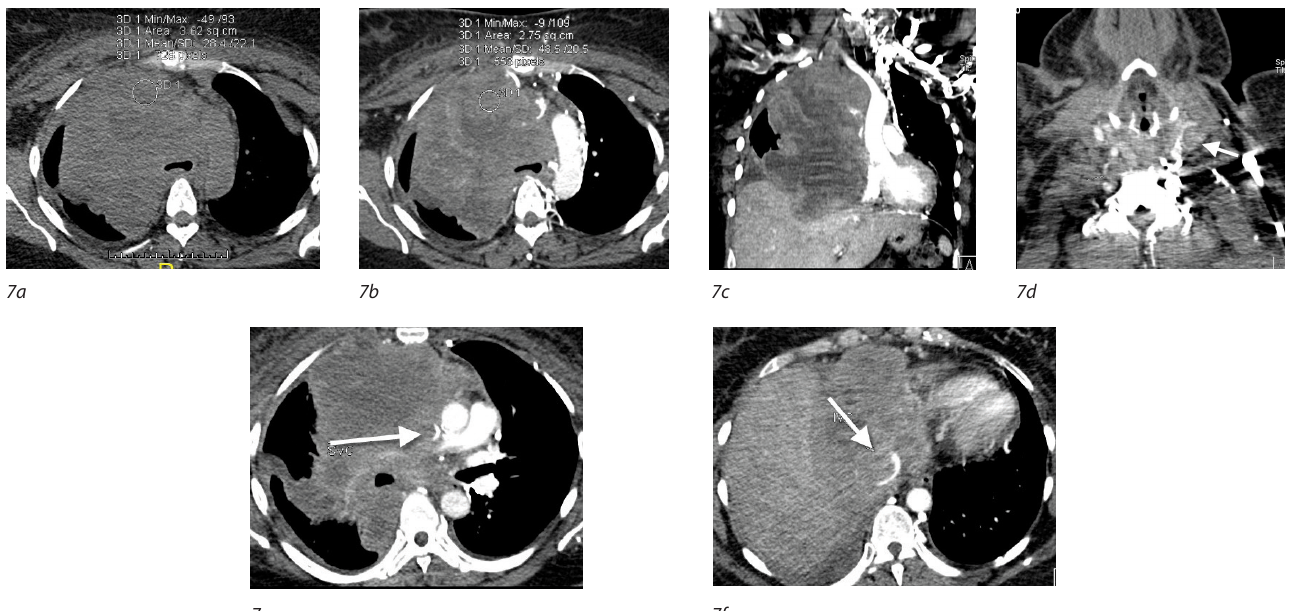
Fig. 7. Mass in right chest with superior medistinal syndrome clinically. The mass seen on precontrast (7a) shows vague enhancement (20HU) on the 60 s scan